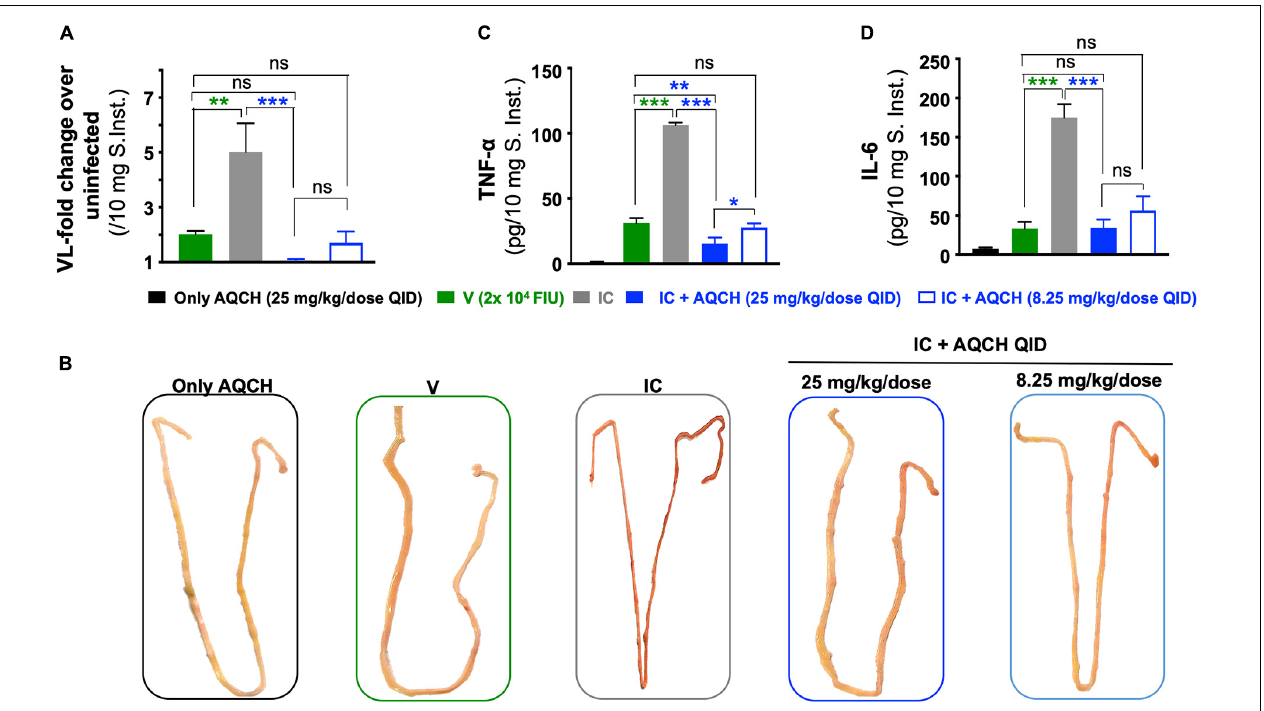
FIGURE 7 | Inhibition of intestinal vascular leakage and reduction in cytokine storm by AQCH in secondary dengue virus (DENV) infection. Secondary dengue AG129 mice ( n = 6) were treated with AQCH either at 25 mg/kg (solid blue bar) or 8.25 mg/kg (empty blue bar) QID dose for 4 days. (A) On day 4, three AG129 mice of each group were examined for vascular leakage in small intestine by Evans blue staining assay. Data are depicted as fold-change in dye staining with reference to an untreated control that had not received any AQCH treatment. A fold-change of 1 corresponds to basal vascular leakage equivalent to untreated group. Remaining three mice of each group were killed on day 4, perfused them with sterile PBS, and luminal content was flushed again with PBS for identification of visual intestinal vascular leakage, a representative vascular leak from each group is shown in panel (B) . Fifty milligrams of small intestines from panel (B) were prepared for determination of TNF- α (C) and IL-6 (D) by enzyme-linked immunosorbent assay, as reported earlier (Shukla et al., 2018). Control groups used in this study were “Only AQCH” group (black bar) and Virus only group (V; green bar); IC group (gray bar) is shown in each of panels. Statistical differences between two groups were calculated through two analysis of variance with Bonferroni correction and shown at top of bar graphs; ns, not significant, * p = 0.01, ** p = 0.001, and *** p <